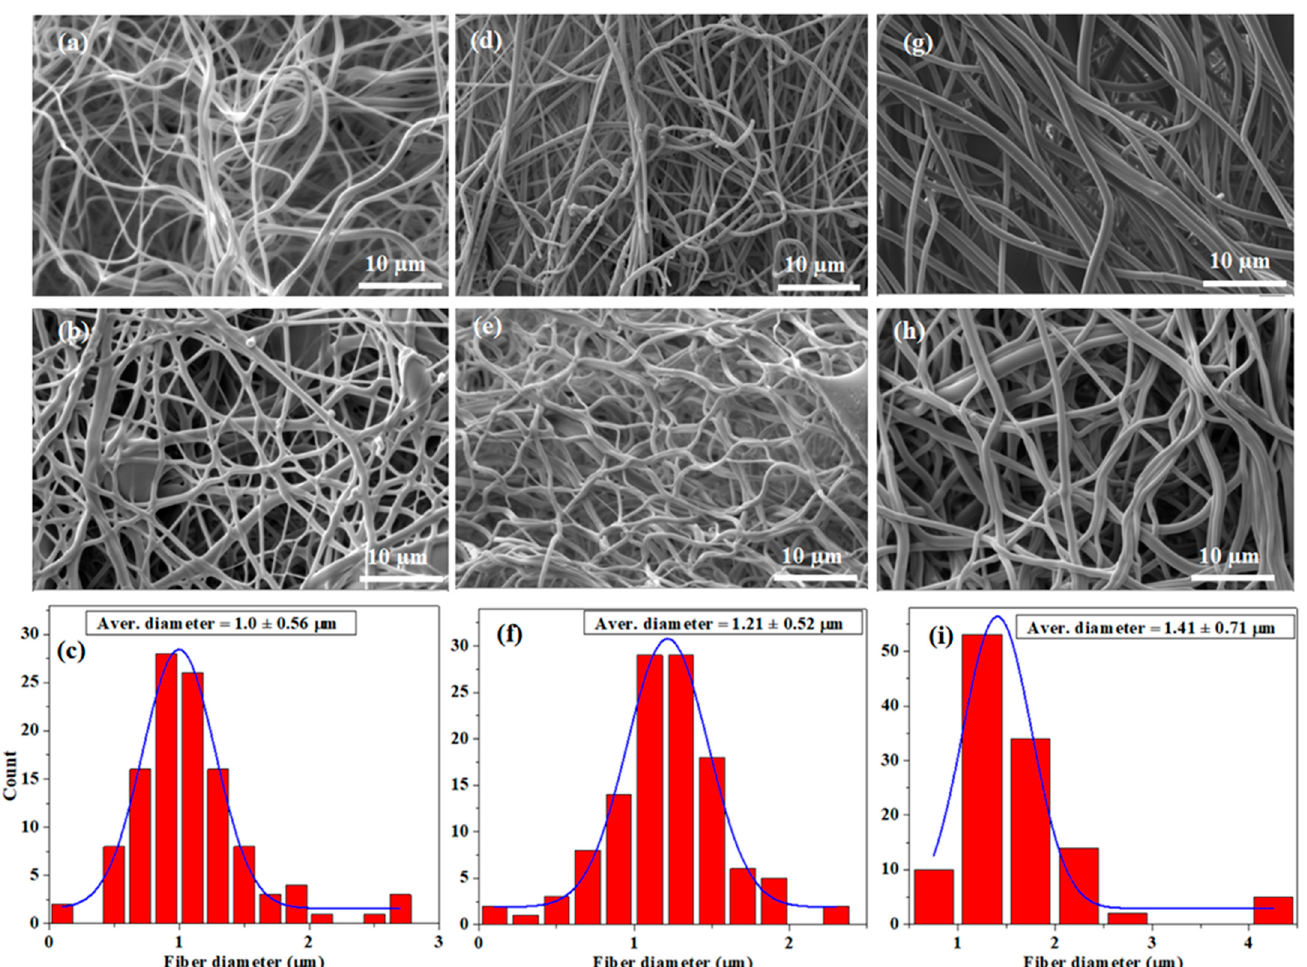
Figure 3. SEM images of ( a , d , g ) noncrosslinked pure GL, GL/OFI1, and GL/OGI2 fiber mates. SEM images and fiber diameter distribution of ( b , c ) pure GL, ( e , f ) GL/OFI1, and ( h , i ) GL/OFI2 crosslinked nanofibers, respectively.